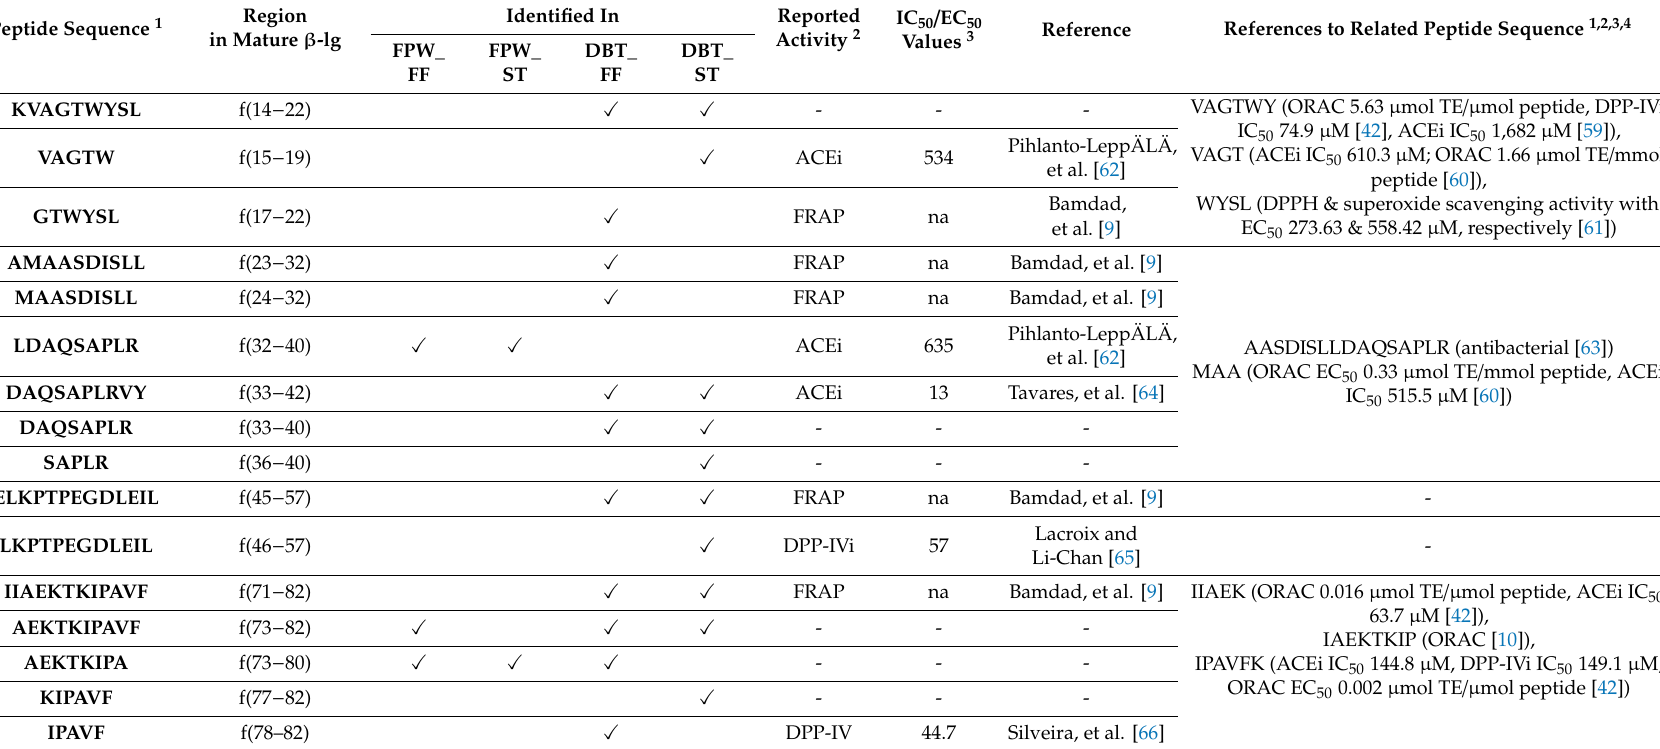
Table 1. Selected β -lactoglobulin ( β -lg)-derived peptides identified in the 4 h whey protein hydrolysates (WPHs) generated using FlavorPro Whey (FPW) and Debitrase (DBT) under pH- and non pH-controlled conditions (ST and FF, respectively) and their bioactive properties as previously reported in the literature (including related peptide